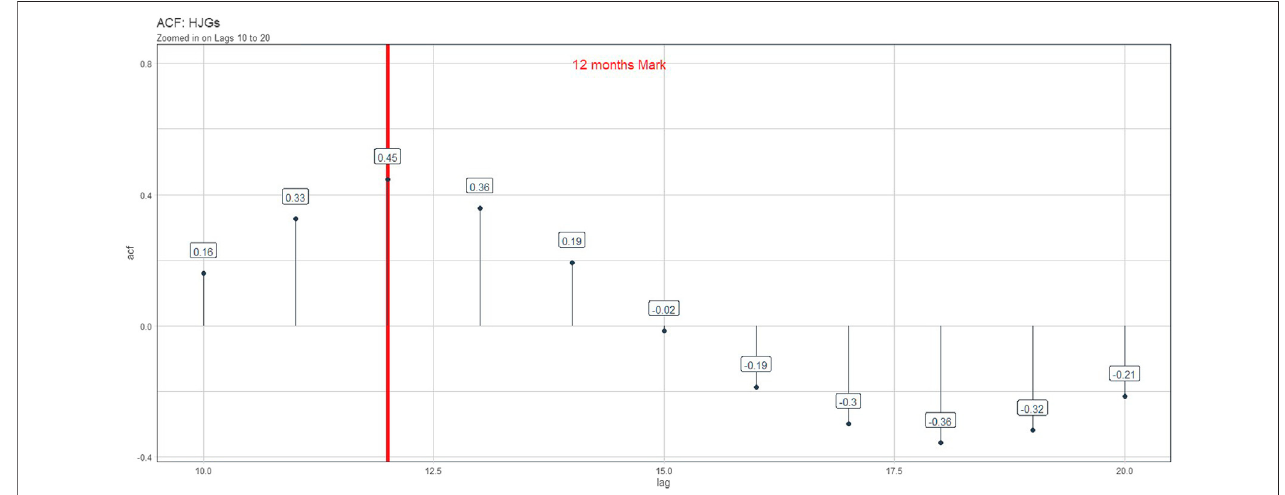
FIGURE 3 | The results of